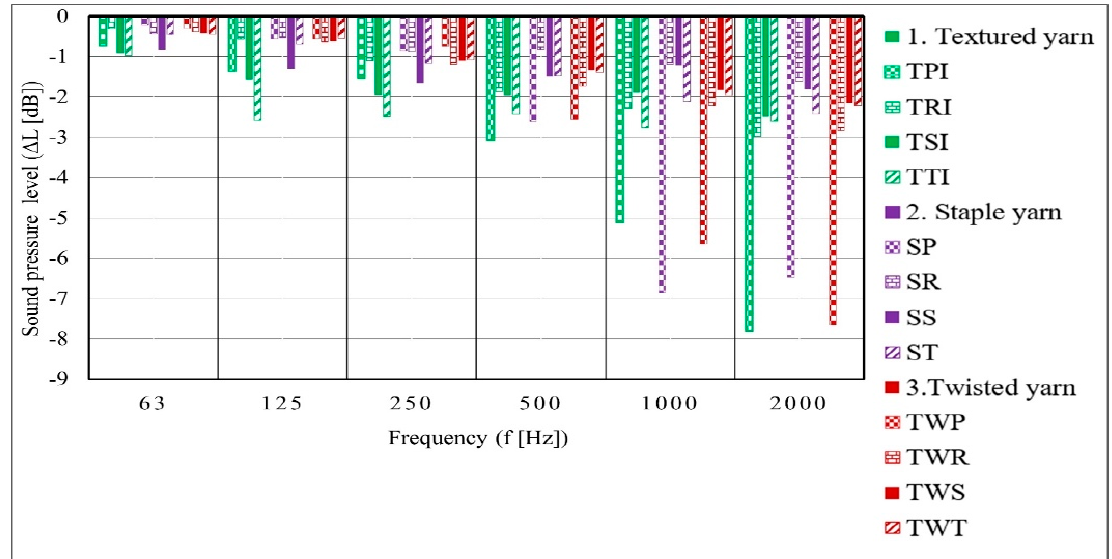
Figure 5. Sound pressure level drop versus frequency range.